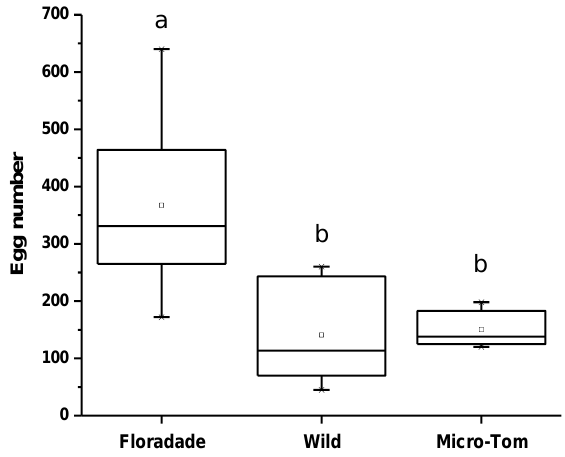
Figure 1. The number of eggs of B. cockerelli in tomato plants of three varieties (Floradade, Wild, and Micro-Tom). Different letters indicate statistical differences ( p < 0.05).